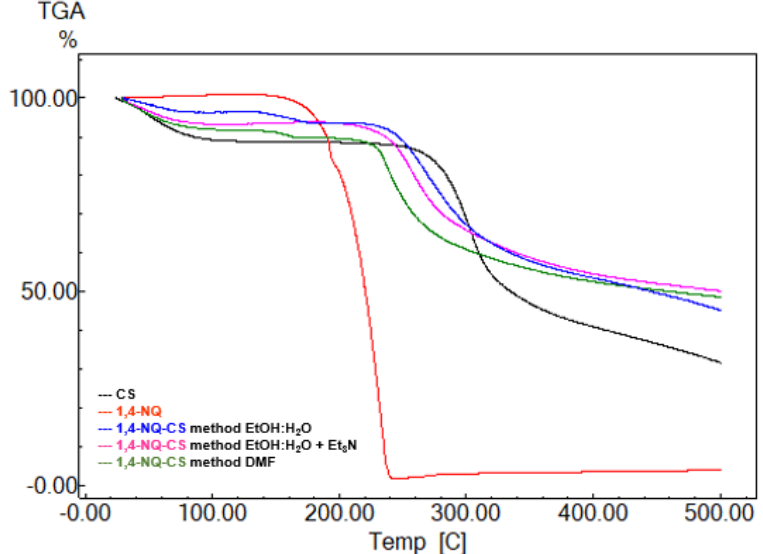
Figure 5. TGA thermograms of 2,3-dichloro-1,4-naphthoquinone (1,4-NQ), chitosan (CS), 1,4-NQ- CS obtained by the EtOH:H 2 O method, 1,4-NQ-CS following the EtOH:H 2 O + Et 3 N method and 1,4-NQ-CS following the DMF method.